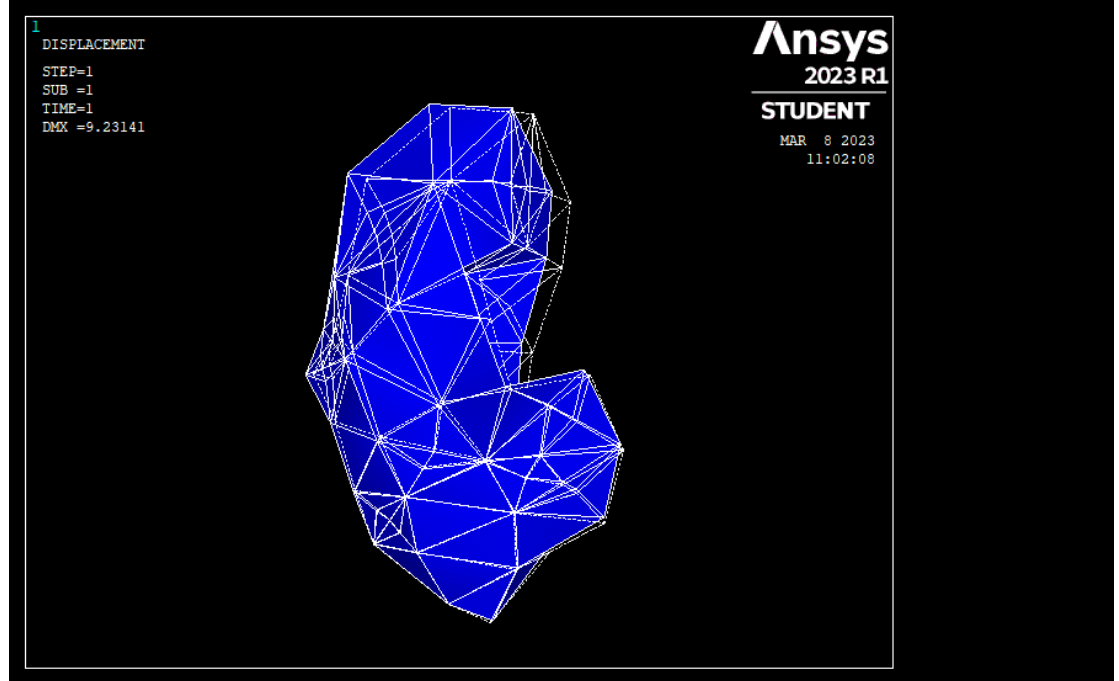
Figure 7. Undeformed and Deformed Geometry for Problem 3 (Linear Analysis).